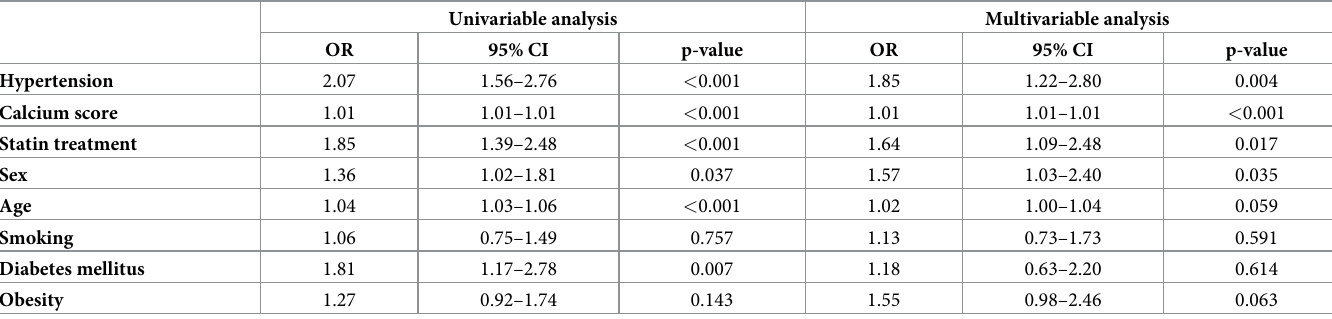
Table 2. Covariables of extensive non-obstructive CAD in univariable and multivariable logistic regression